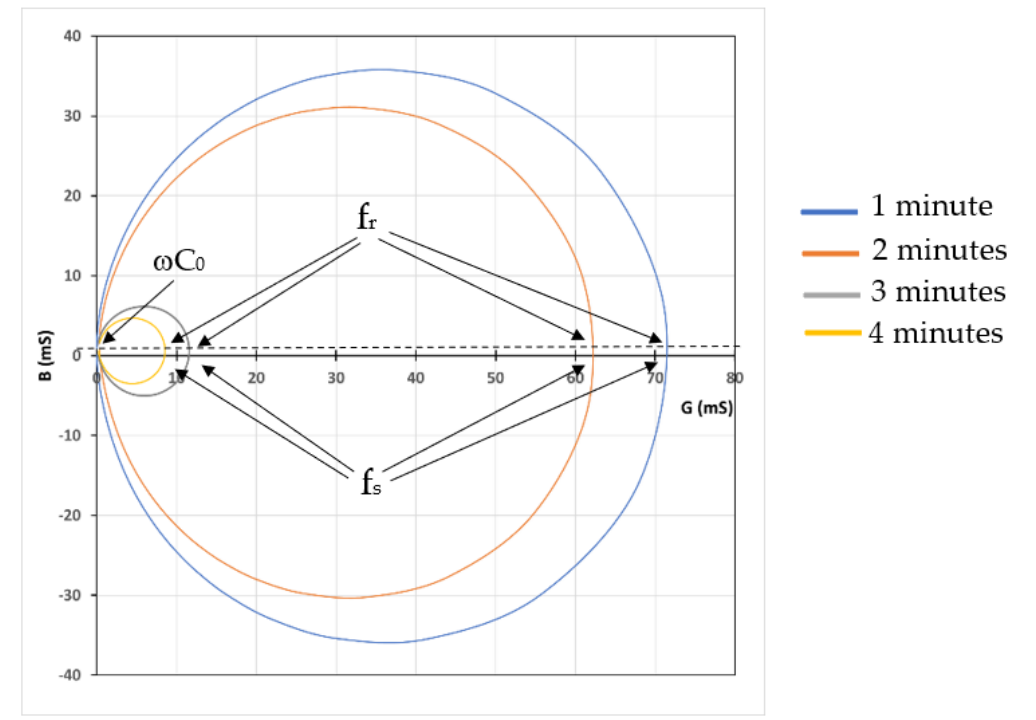
Figure 10. The admittance locus for a QCM with SA layer deposited at various durations. The intersections between the horizontal axis and the circles represent the motional series resonance (f s ), while the ones between the dotted line and the circles represent the compound resonance (f r ).